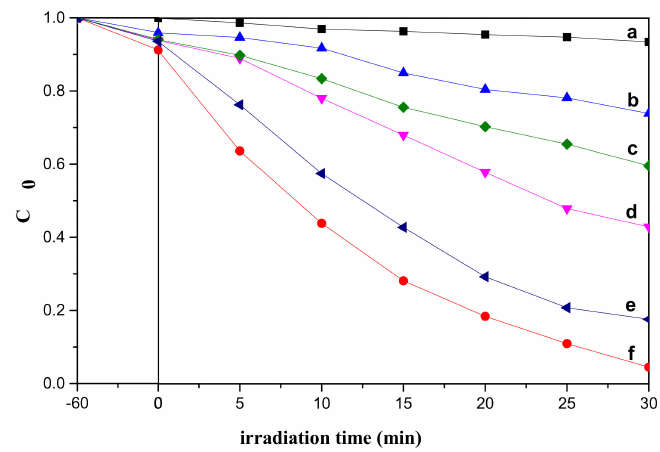
Figure 6. Photocatalytic degradation of MB by different photocatalysts under UV-vis light irradiation: ( a ) without catalyst; ( b ) 0.5 h; ( c ) 2 h; ( d ) 6 h; ( e ) 10 h after calcination; ( f ) 10 h.